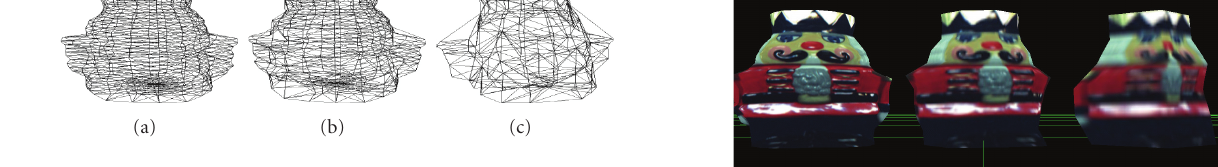
Figure 1: Nutcracker-toy model at various mesh resolution levels.